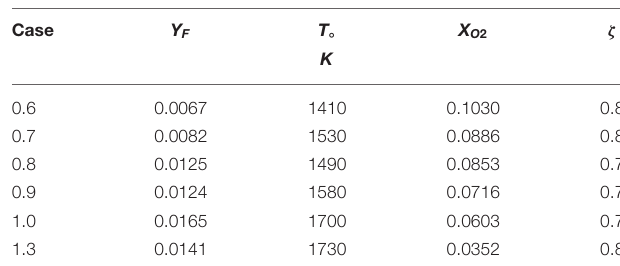
TABLE 2 | Dilution characteristics for which the condition in Equation (20) is not met and diluted mixtures are described by smooth S-Shaped Curves (see Figure 5